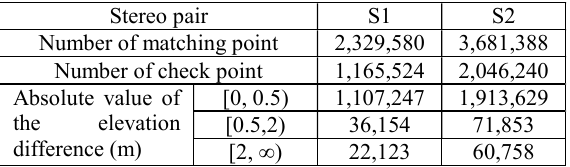
Table 2. Statistic results of elevation difference of the frame images.